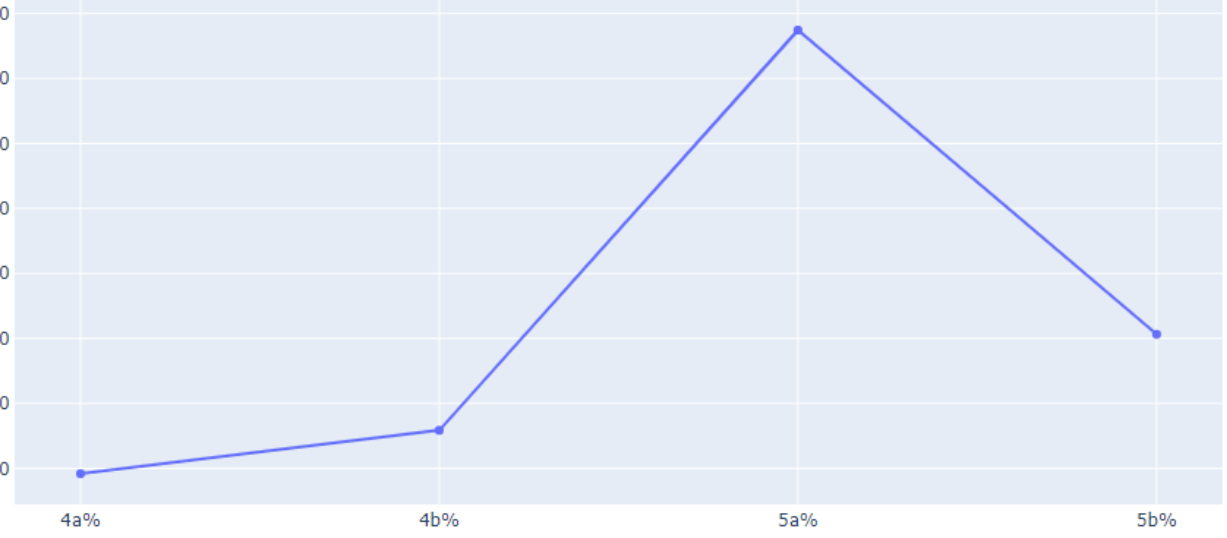
7 Figure 5. The number of residents using social networks and the number of residents participating in recreational and socializing activities before and after the COVID-19 pandemic.